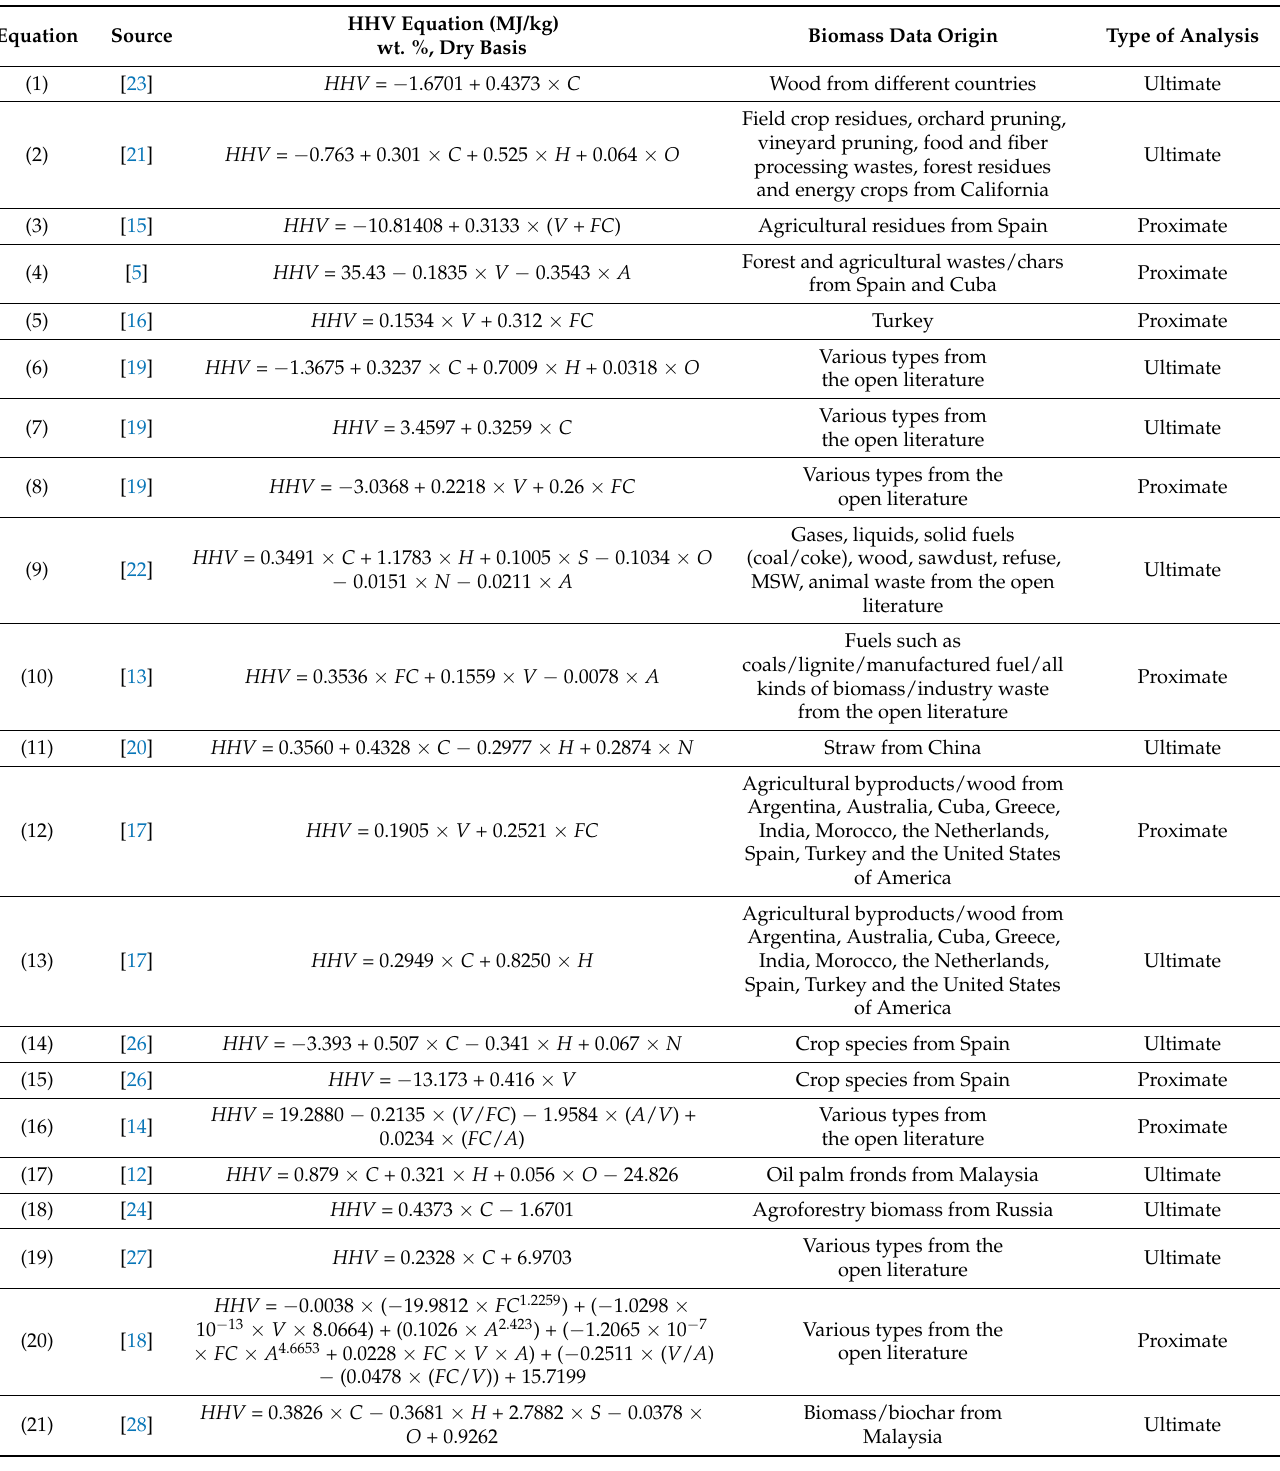
Table 1. Equations to determine HHVs from proximate analysis (volatiles (V), fixed carbon (FC) and ash (A)) or elemental analysis (carbon (C), hydrogen (H), oxygen (O), nitrogen (N), sulfur (S) and ash